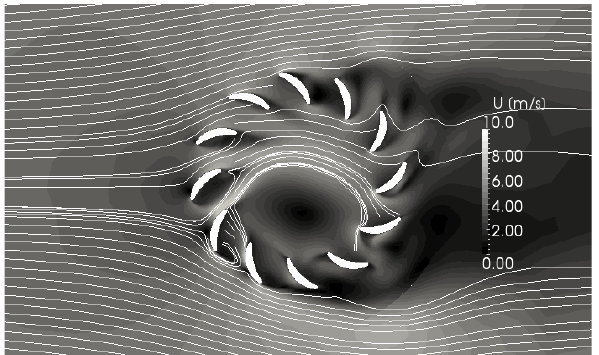
Figure 9. Smoke streamlines of a cross-flow wind turbine ( D = 114 mm, λ = 0.4, and U ∞ = 6 m/s).